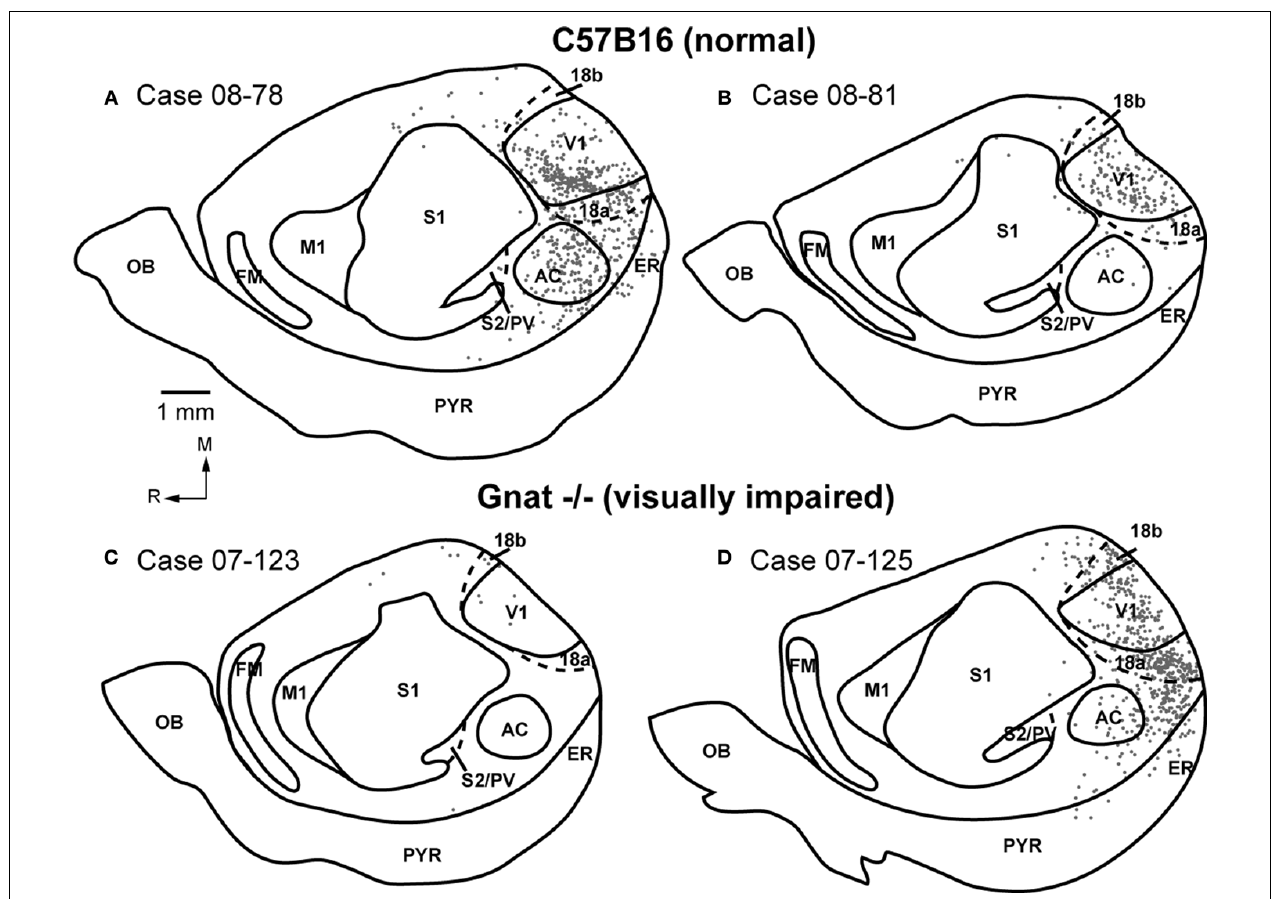
FIGURE 8 | Contralateral Cortical Reconstructions of Neuroanatomical Tracer Injections in V1. Reconstructions of cortical connections in C57Bl6 (A,B) and Gnat − / − (C,D) mice showing the location of retrogradely labeled cell bodies from neuroanatomical tracer injections in V1 relative to the architectonically defi ned cortical fi elds. The dots mark the locations of